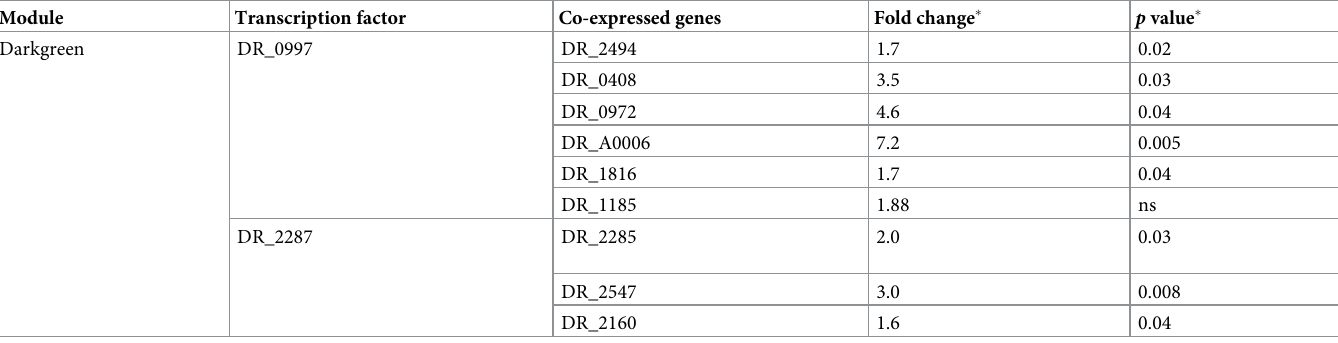
Table 3. Validation of co-expressed genes with transcription factors in a darkgreen module.